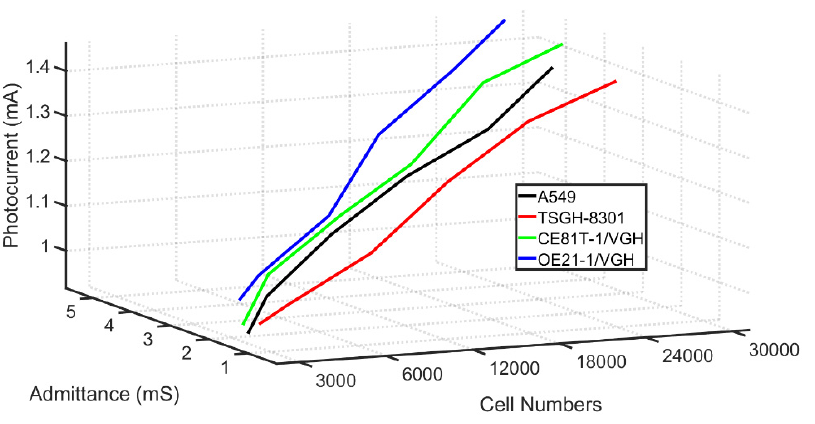
Figure 5. Three-dimensional plot of photocurrent response and admittance value measurement of the different cells.